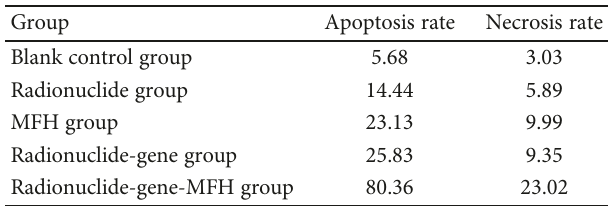
Table 1: Flow cytometric analysis of apoptosis and necrosis in di ff erent therapy groups